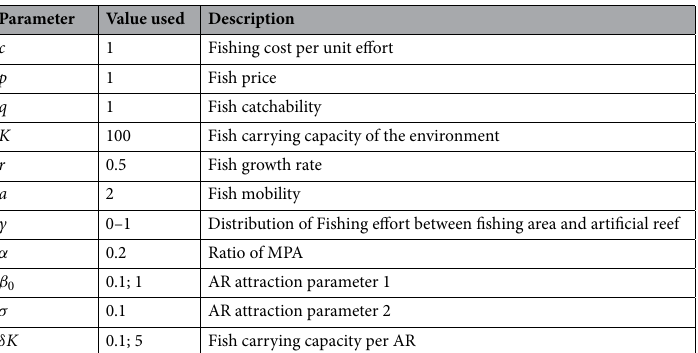
Table 1. Values of the parameters in the mathematical model describing changes to fishing effort and fish population growth depending on the volume of the artificial reef and distribution of fishing effort. MPA Marine Protected Area, AR Artificial Reef.